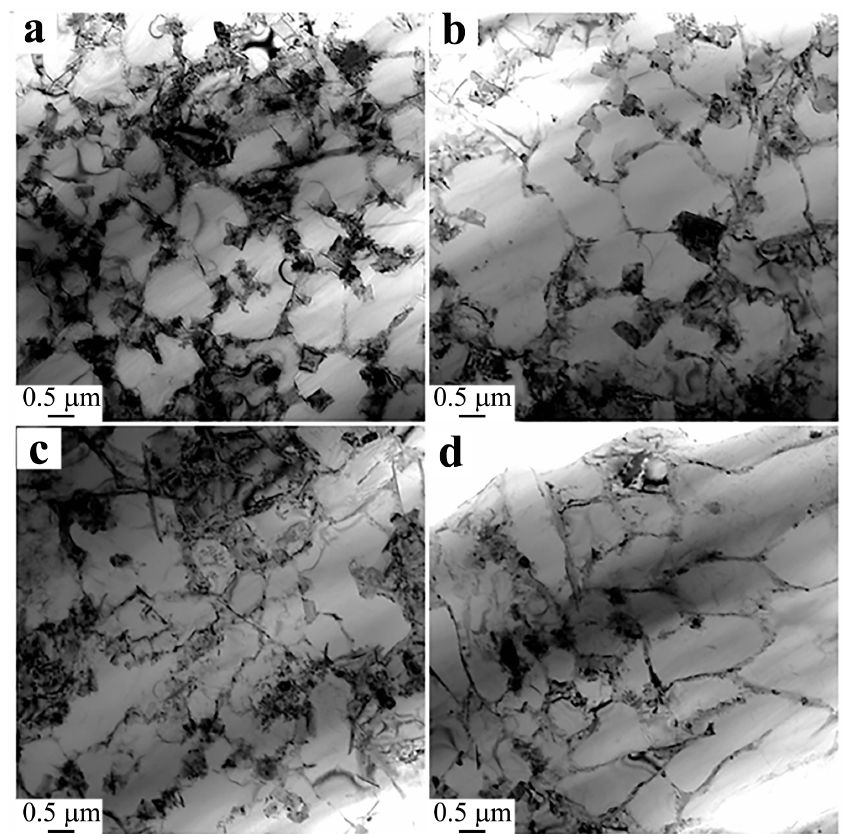
Figure 2. Structure of Al-11wt%Si alloy subjected to complex modification: a – d – layers located at distances of 20 μm; 40 μm, 65 μm, 80 μm from the surface of treatment,